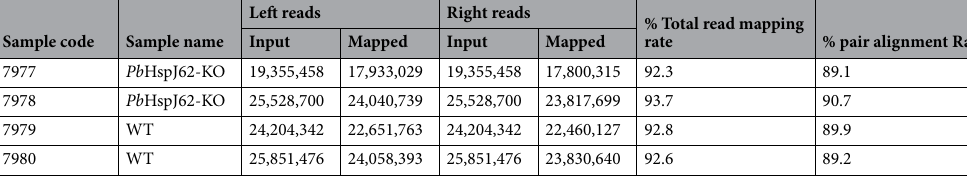
Table 1. Detail of mapped reads with the P. berghei